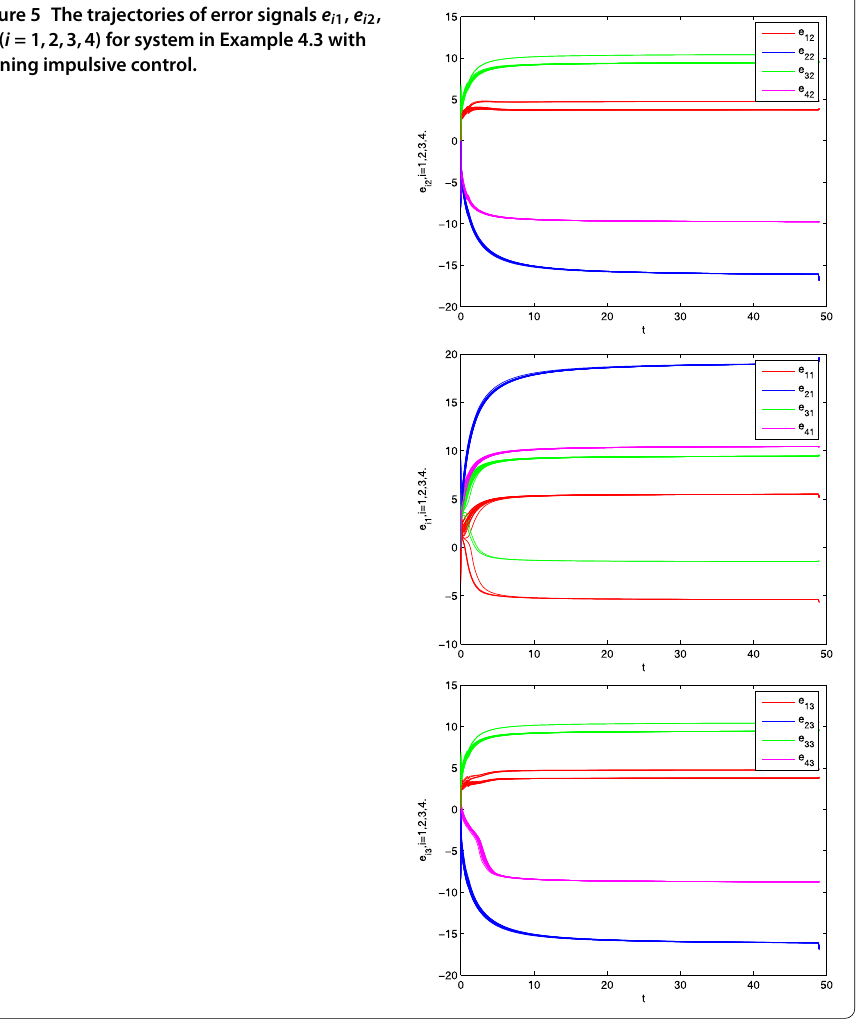
Figure 5 The trajectories of error signals e i 1 , e i 2 ,